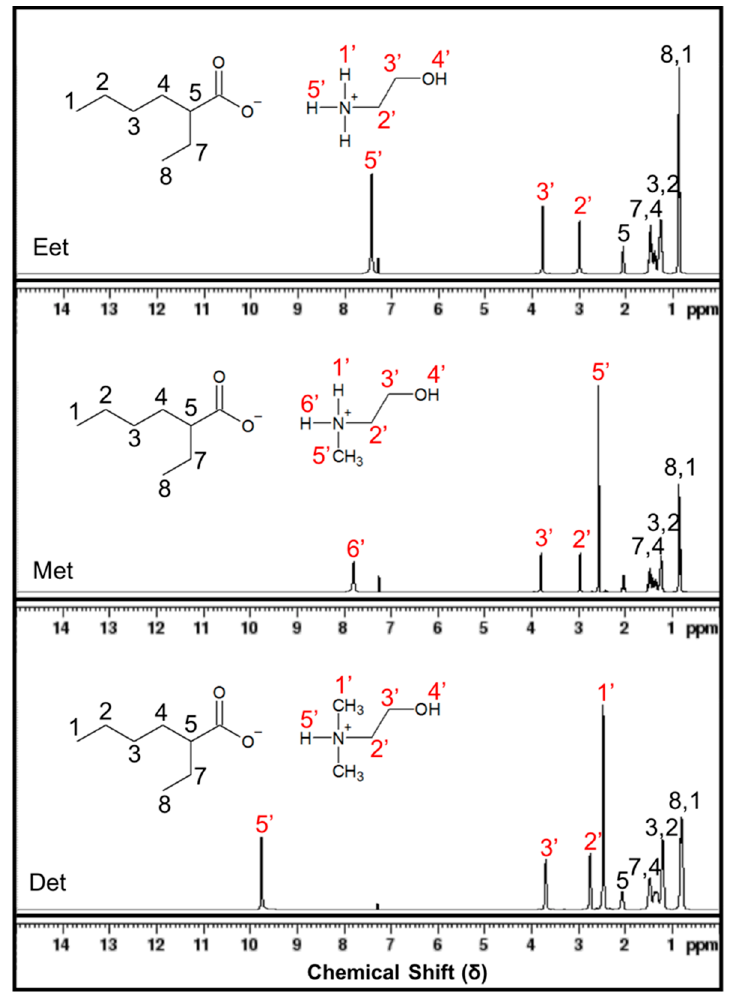
Figure 1. 1 H NMR spectra for PILs of Eet, Met, and Det.